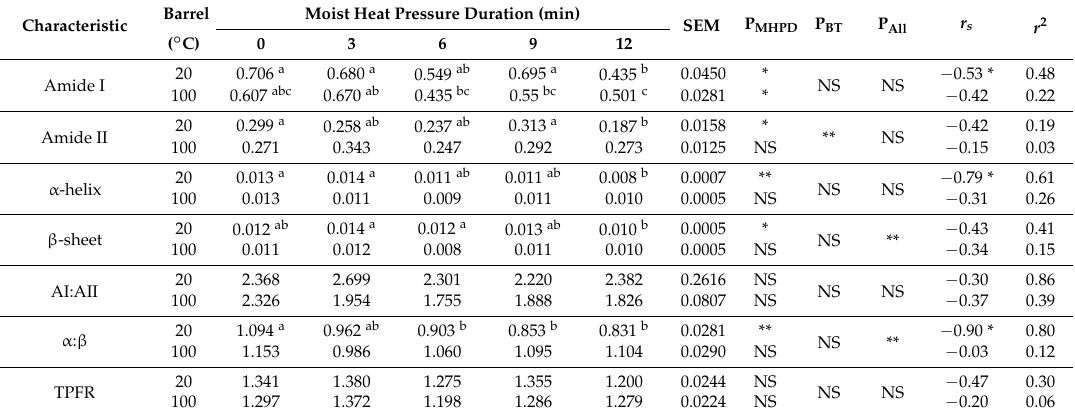
Table 4. Changes in protein molecular structure of cold-pressed (20 ◦ C) and expeller (100 ◦ C) canola meals with moist heat pressure treatment for durations of 0, 3, 6, 9 or 12 min. Barrel Moist Heat Pressure Duration Characteristic